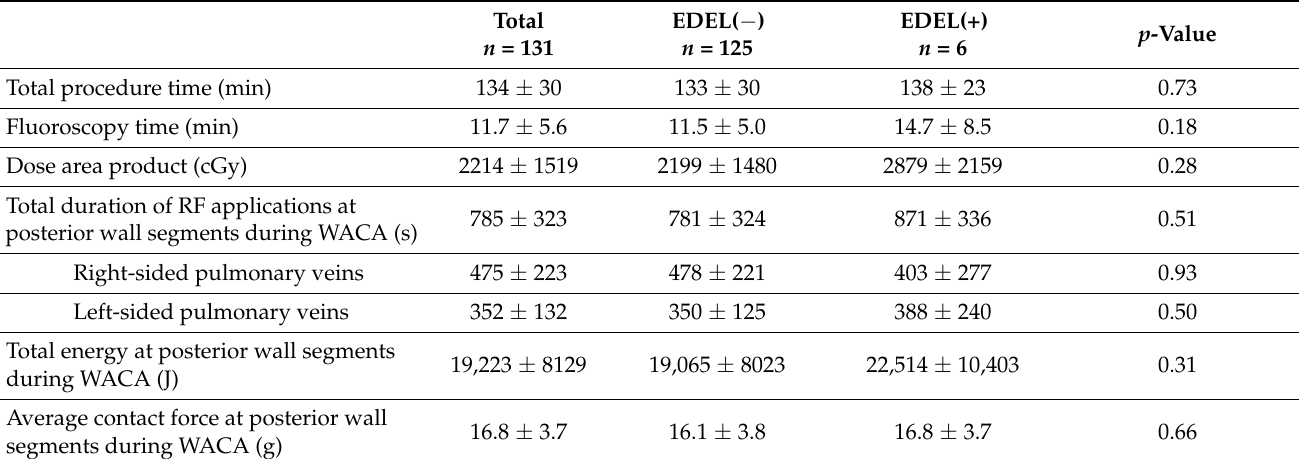
Table 2. Procedural